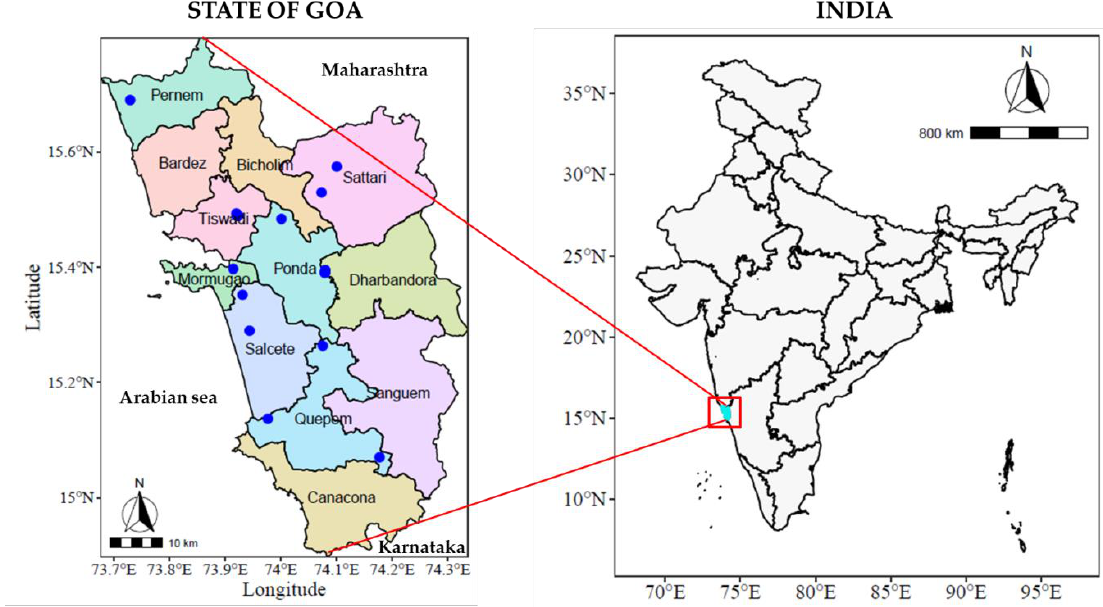
Figure 2. Sampling locations of the study. The blue dots on the State of Goa map indicates the locations of orchards of leaf sampling.